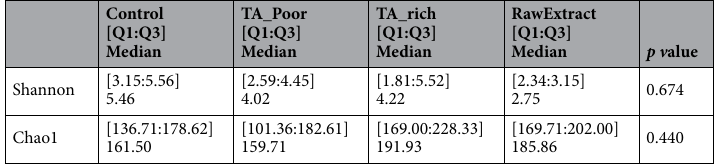
Table 2. Shannon and Chao1 alpha-diversity indexes of the samples.